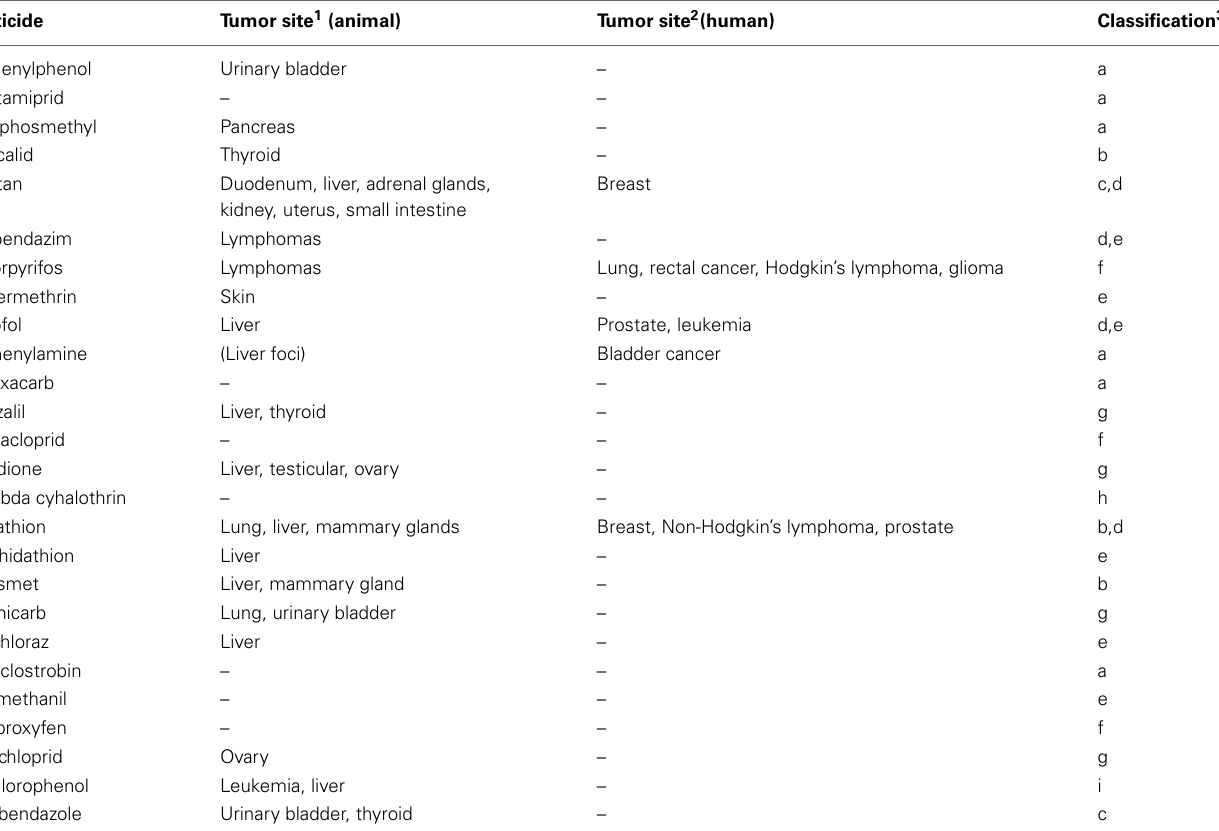
Table 2 | Tumor data reported in PubMed, cancer classifications by US-EPA and IARC for the pesticides most frequently detected in apples and oranges on the Swedish market